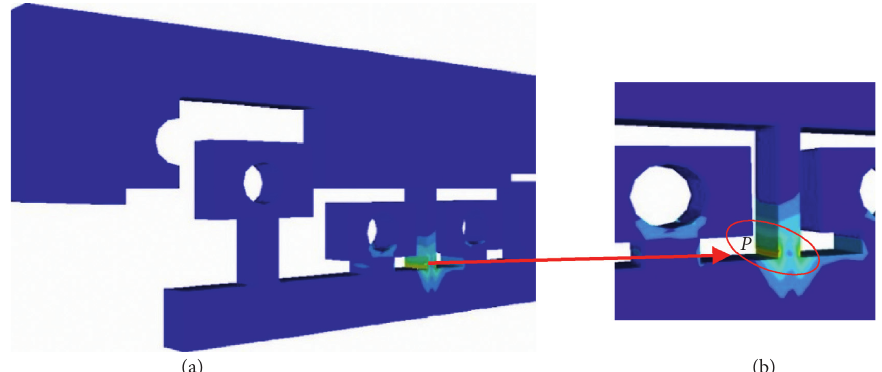
Figure 12: Mises stress distributions of the fixture. (a) Fixture. (b) Partial enlarged